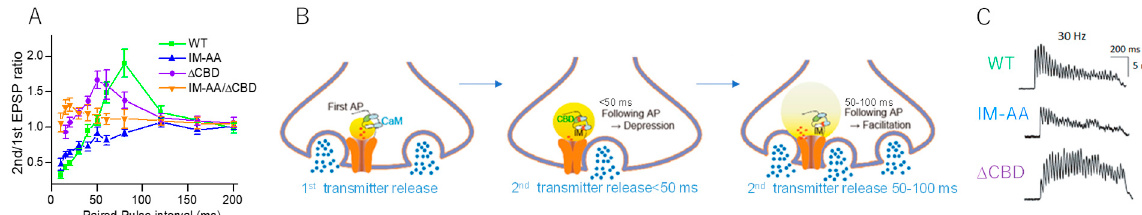
Figure 6. AP modulates synaptic transmission via Ca V 2.1 channel regulation. Ca V 2.1 channel, wild type (WT), alanine mutation at the IQ-like motif (IM), or deletion of the CaM-binding domain ( ∆ CBD) was expressed in presynaptic neurons and EPSPs were recorded in the presence of a blocker for native Ca V 2.2 channels. ( A ) Paired-AP alters the second EPSP amplitude. Timing of the second AP-induced depression and facilitation of synaptic transmission. Depression was prevented by ∆ CBD, while facilitation was prevented by IM-AA mutation of the pore-forming α 1 subunit. ( B ) Model for Ca 2+ /CaM-dependent inactivation and facilitation of the Ca V 2.1 channel and neurotransmitter release. ( C ) Biphasic synaptic transmission during 1-s APs at 30 Hz changed to synaptic depression by IM-AA or synaptic facilitation by ∆ CBD mutation. Adapted from Mochida et al., 2008